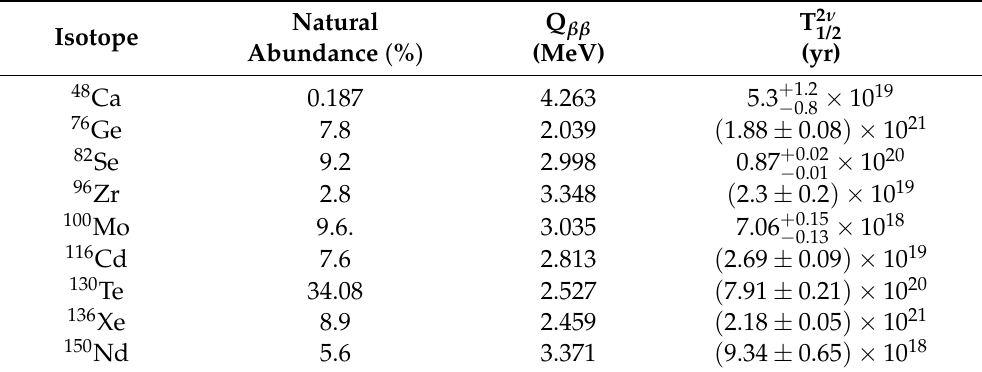
Table 1. A list of isotopes mostly used in 2 νββ decay experiments. Some of the key features are reported. Half-life values are from